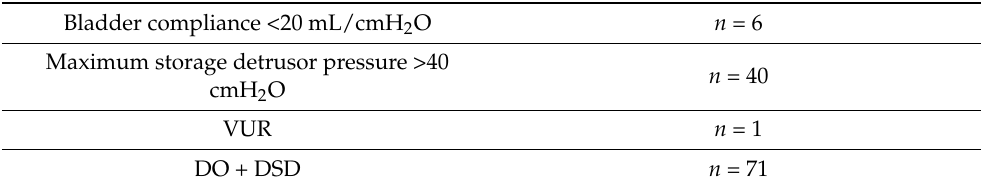
Table 3. Urodynamic risk factors for upper urinary tract damage.